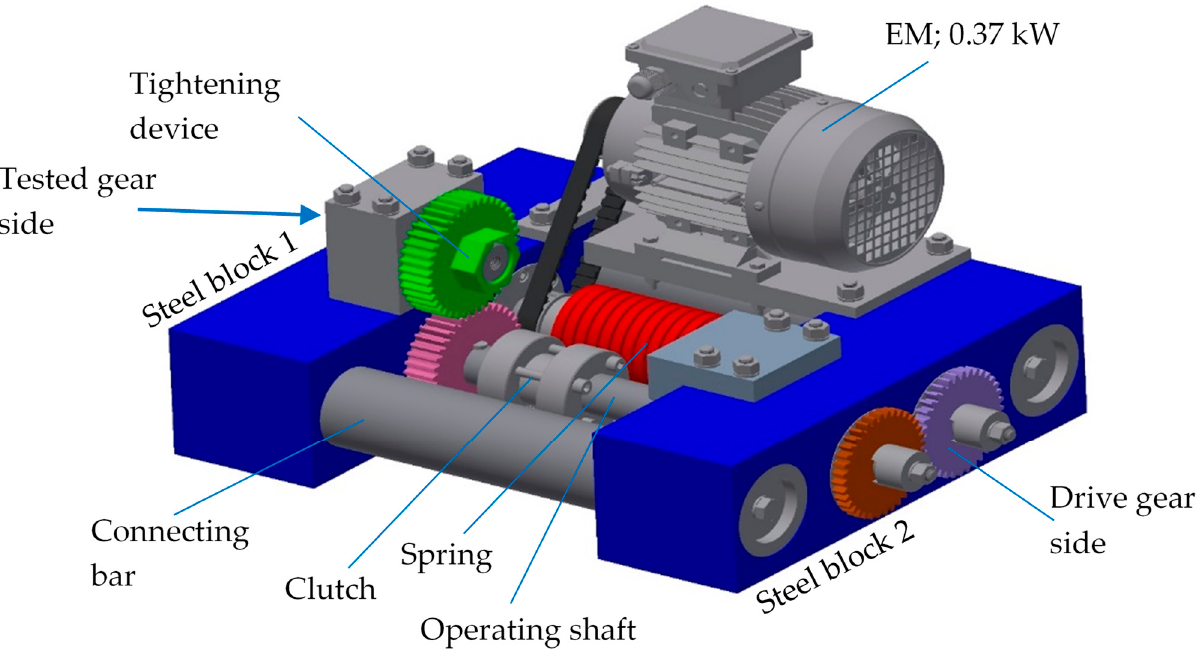
Figure 2. The prototype of the gear test rig.